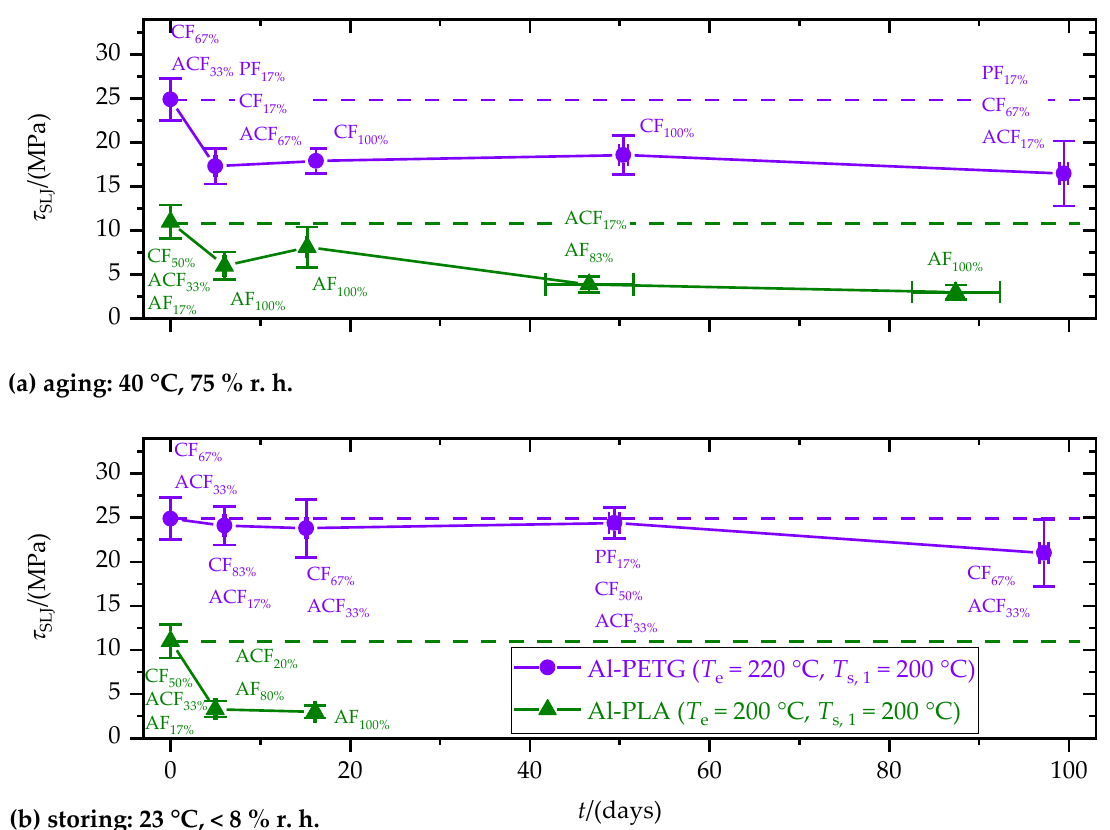
Figure 12. Tensile single-lap-shear strength, τ SLJ , as a function of ( a ) aging and ( b ) storage time, t. Percentages of the failure patterns polymer: part failure (PF, outside the joining area), cohesive failure (CF), adhesive failure (AF) and mixed adhesive and cohesive failure (ACF) are given.